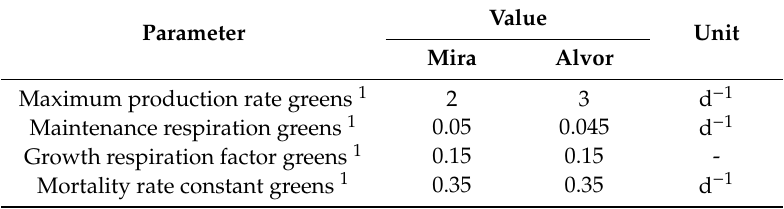
Table 1. Parameters used in the WAQ